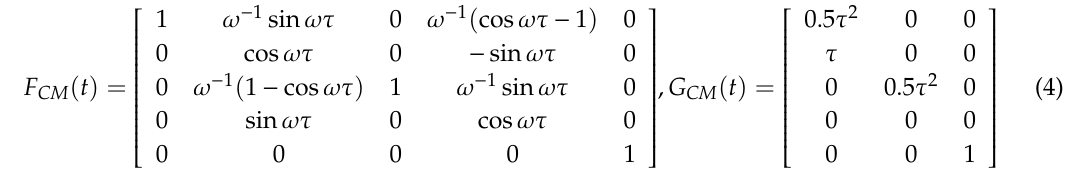
O h is the output at t t